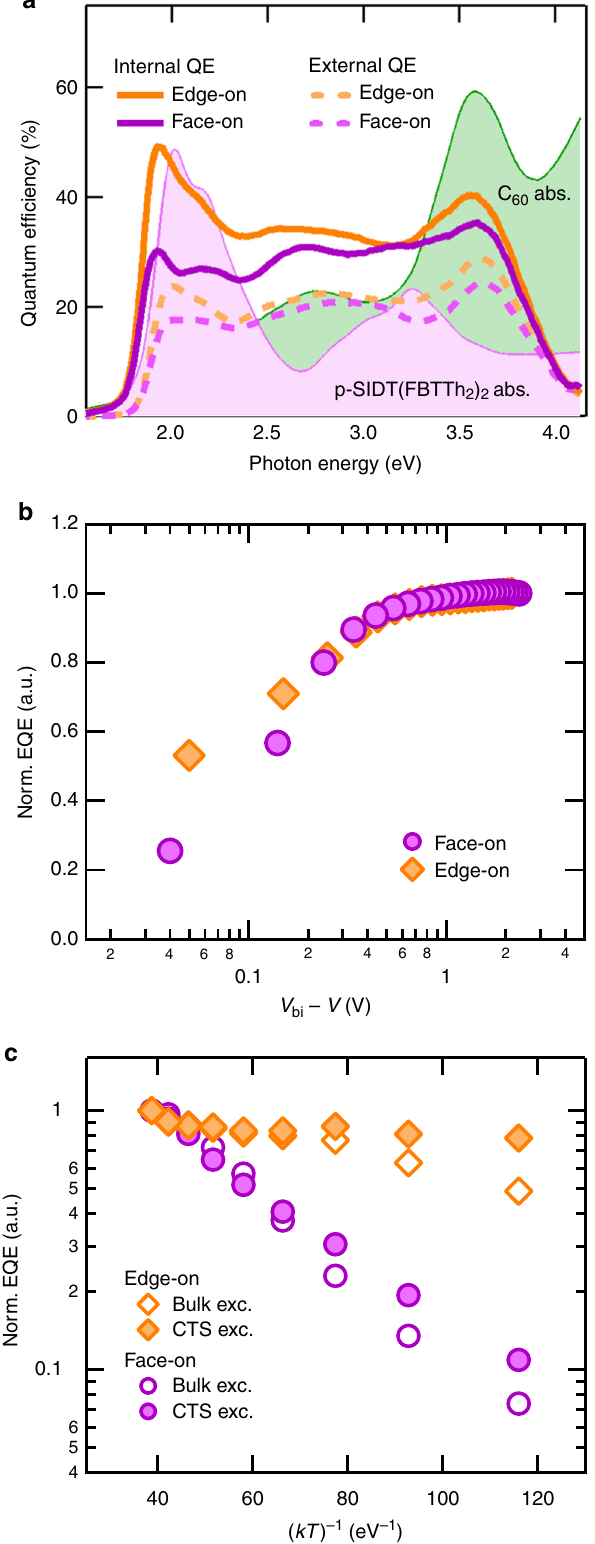
Fig. 4 Ef fi ciency of charge generation. a EQE ( dashed lines ) and IQE ( continuous lines ) spectra of bilayer solar cells with varying orientation. The absorption spectra of p-SIDT(FBTTh 2 ) 2 and C 60 are plotted in the background for reference. b Bias-dependent EQE values corresponding to p-SIDT(FBTTh 2 ) 2 absorption, integrated and normalized to the value under the highest fi eld. The applied bias was corrected for the built-in potential. c Temperature-dependent EQE values, integrated and normalized to the value at room temperature. Open symbols are EQE values integrated over bulk absorption, and full symbols are EQE values integrated only for CT state